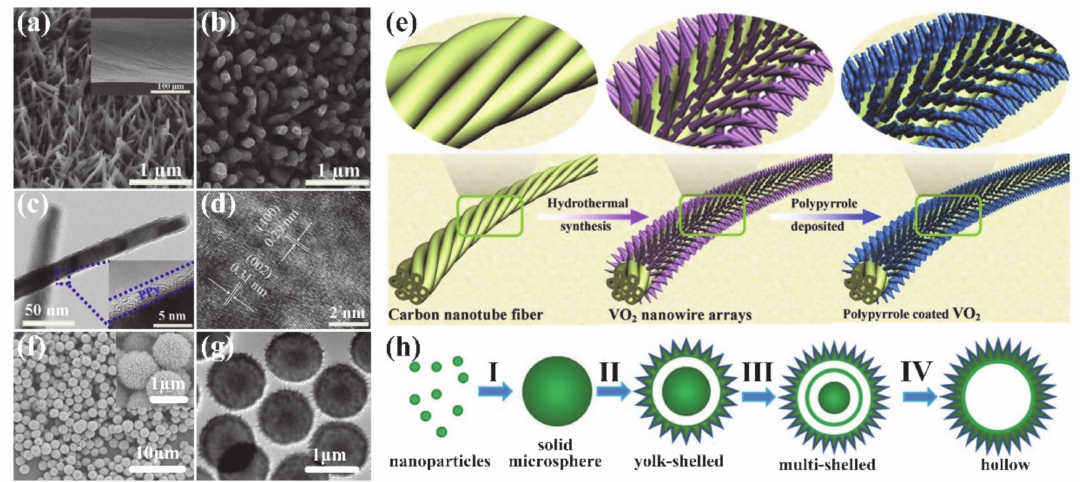
Figure 7. ( a ) SEM images of VO 2 NWAs; the inset in ( a ) is a low-magnification SEM image of the VO 2 /CNTF hybrid fibers. ( b ) SEM image of VO 2 @PPy NWAs. ( c ) Low-magnification TEM image of VO 2 @PPy. ( d ) High-resolution TEM image of VO 2 . ( e ) Schematic diagram of the fabrication process about the VO 2 @PPy/CNTF electrode. Reproduced from [66], with permission from Elsevier, 2018. ( f ) Low-magnification SEM image of VO 2 ; inset is a high-magnification SEM image. ( g ) Corresponding TEM image. ( h ) Structural evolution of the VO 2 microspheres. Reproduced from [67], with permission from John Wiley and Sons,